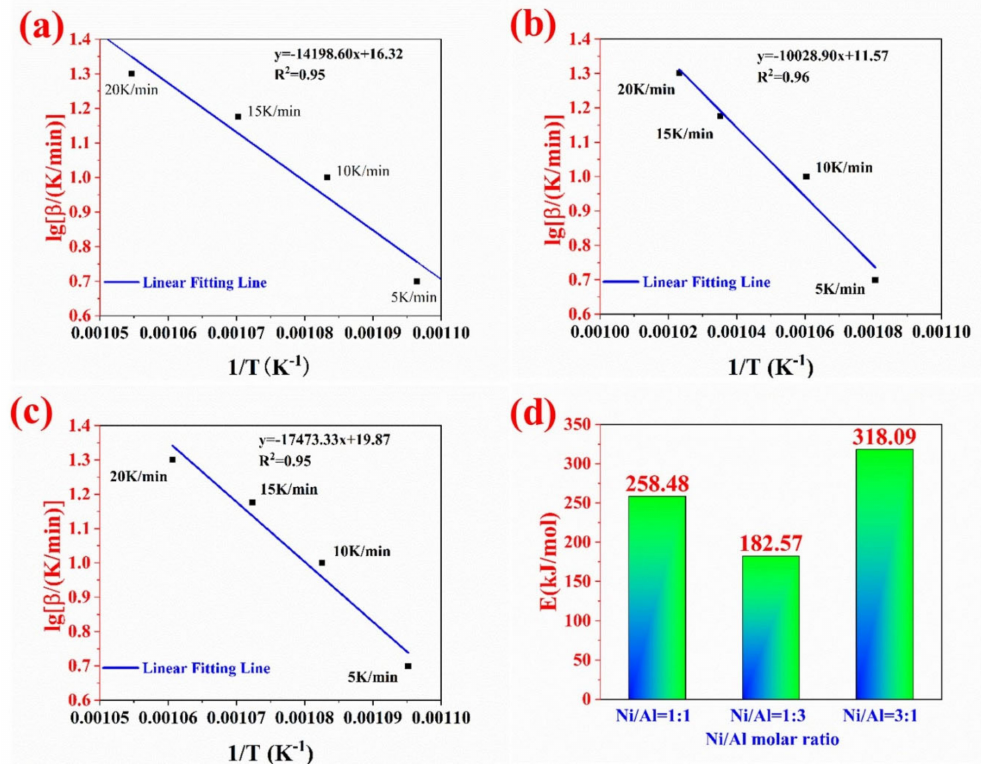
Figure 4. Linear fitting of samples at different heating rates ( a ) Ni/Al = 1:1, ( b ) Ni/Al = 1:3, and ( c ) Ni/Al = 3:1; ( d ) the apparent activation energy E of the samples. Figure 4d showed that the apparent activation energy E of Ni:Al = 1:1, 1:3, and 3:1 are 258.48 kJ/mol, 182.57 kJ/mol, and 318.09 kJ/mol, respectively. When the contents of